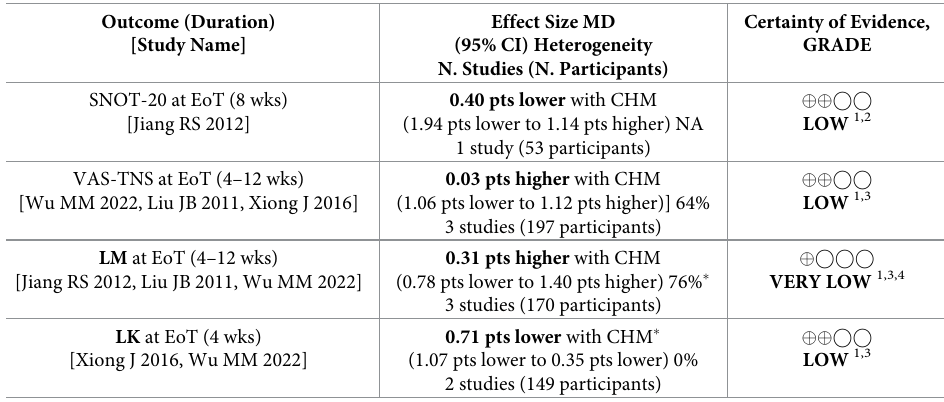
Table 5. GRADE for oral Chinese herbal medicine versus pharmacotherapy for chronic rhinosinusitis: All studies.